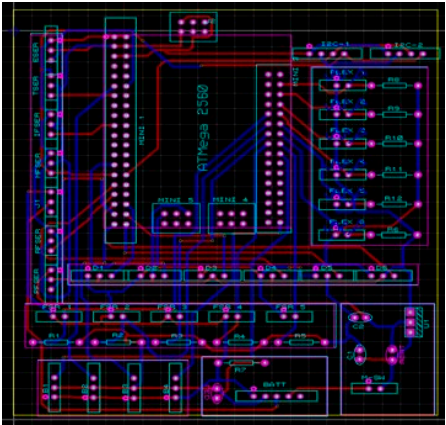
Figure 11. PCB layout of the PCB designed.